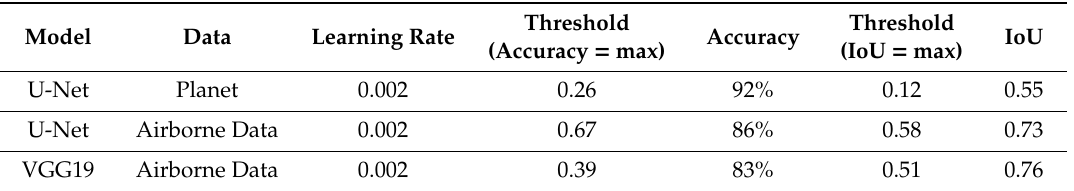
Table 3. Test results for di ff erent model types on di ff erent data and thresholds with aerial labeling.